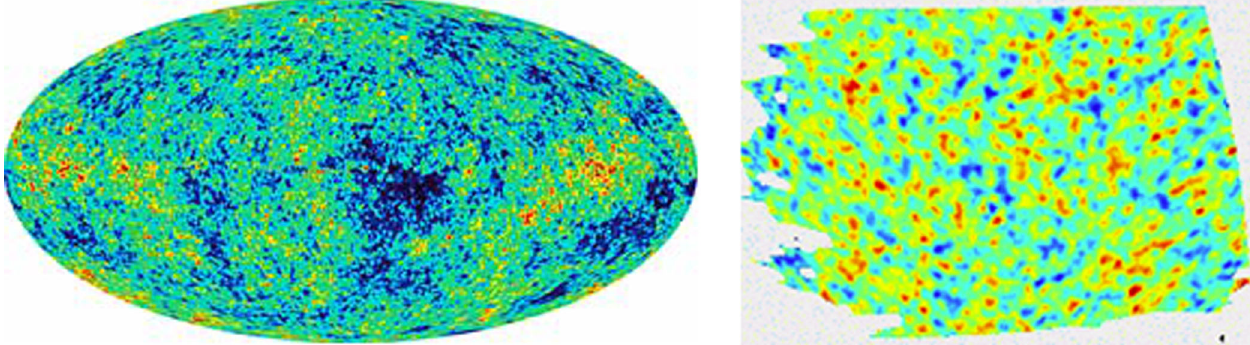
FIG. 2. (Left) An elliptical map of the CMB. Credit: WMAP. 3 (Right) A rectangular map of the CMB. From BOOMERANG.